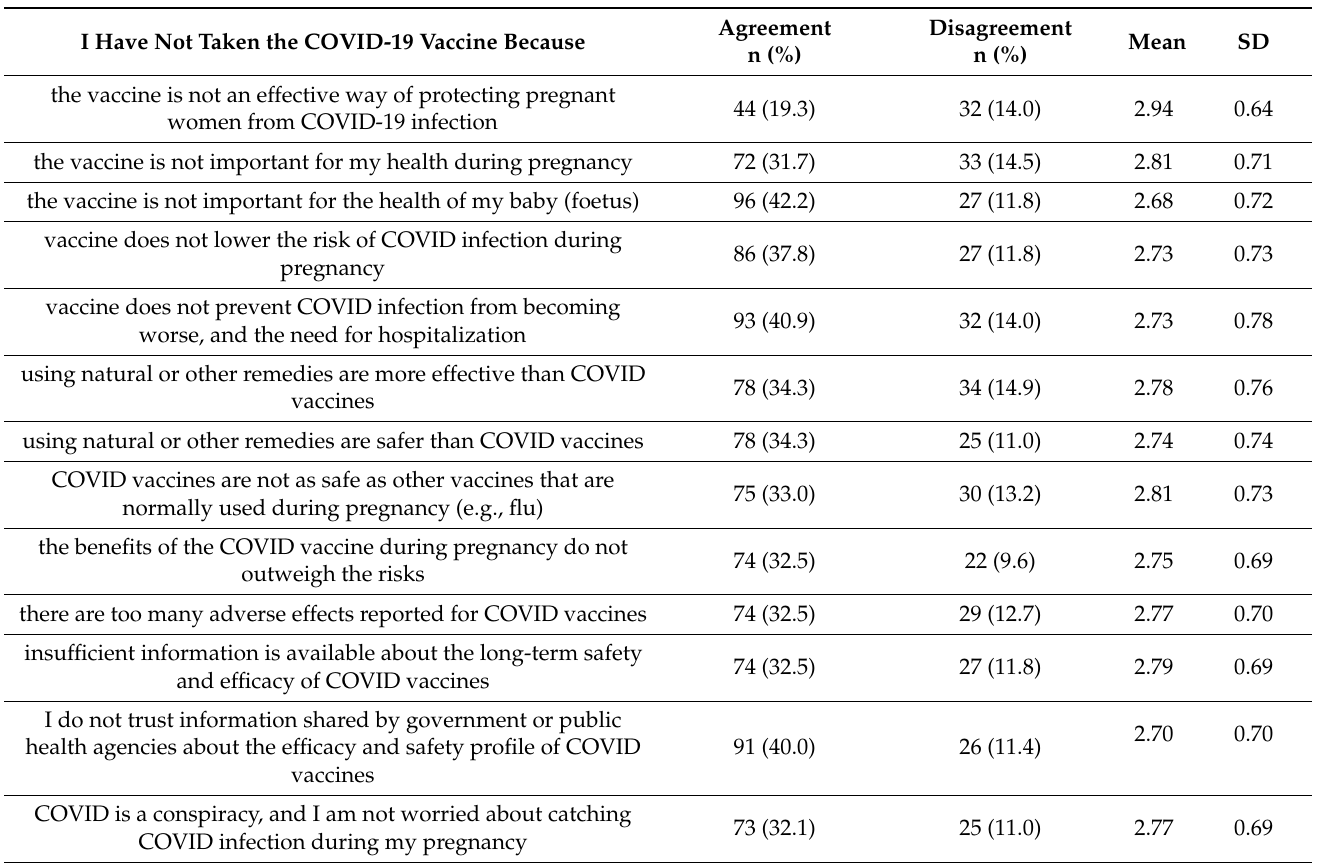
Table 5. Responses to items measuring hesitancy among unvaccinated pregnant women (n = 227).